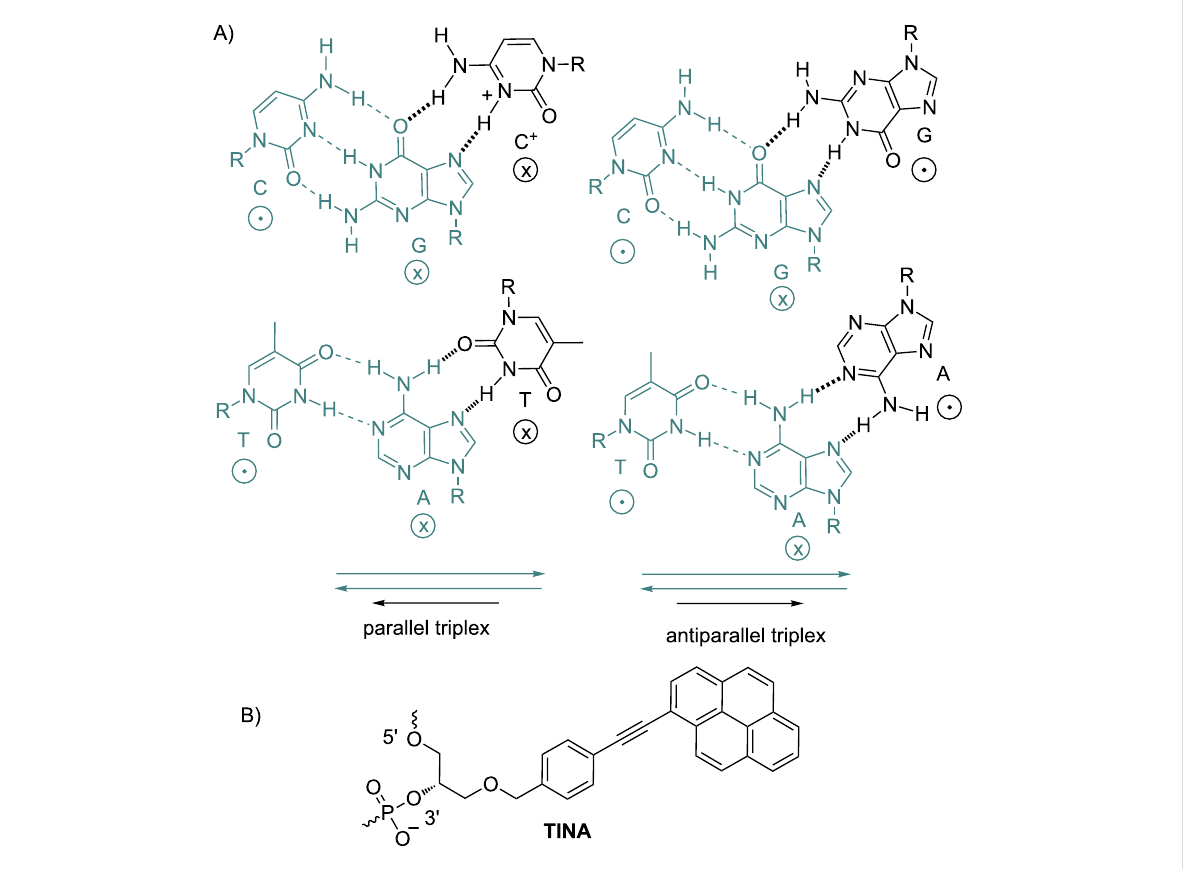
Figure 1: A) Formation of nucleotide triplets in parallel and antiparallel (relatively to polypurine strand) complexes. The relative orientations of DNA backbones are shown by the symbols “ ” and “ ”. The duplex is in green, TFO is in black. B) Chemical structure of the TINA molecule inserted in the TFO structure of the DNA triplex as a